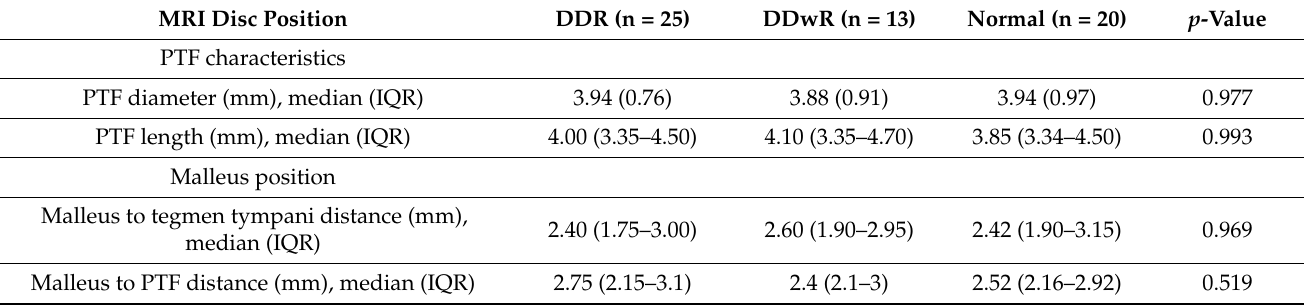
Table 3. The PTF characteristics and malleus position according to MRI disc